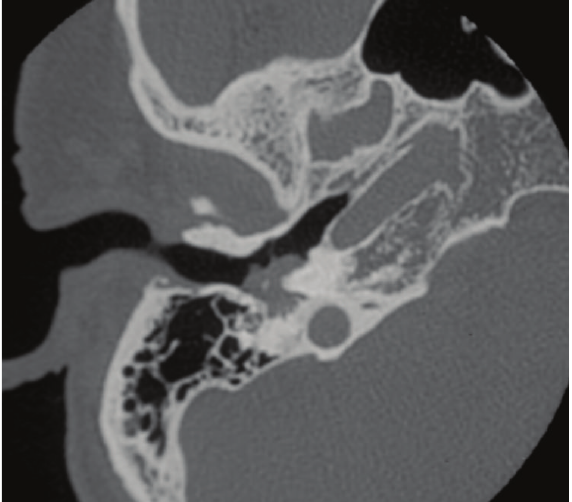
Figure 2: Computer tomogram at presentation.